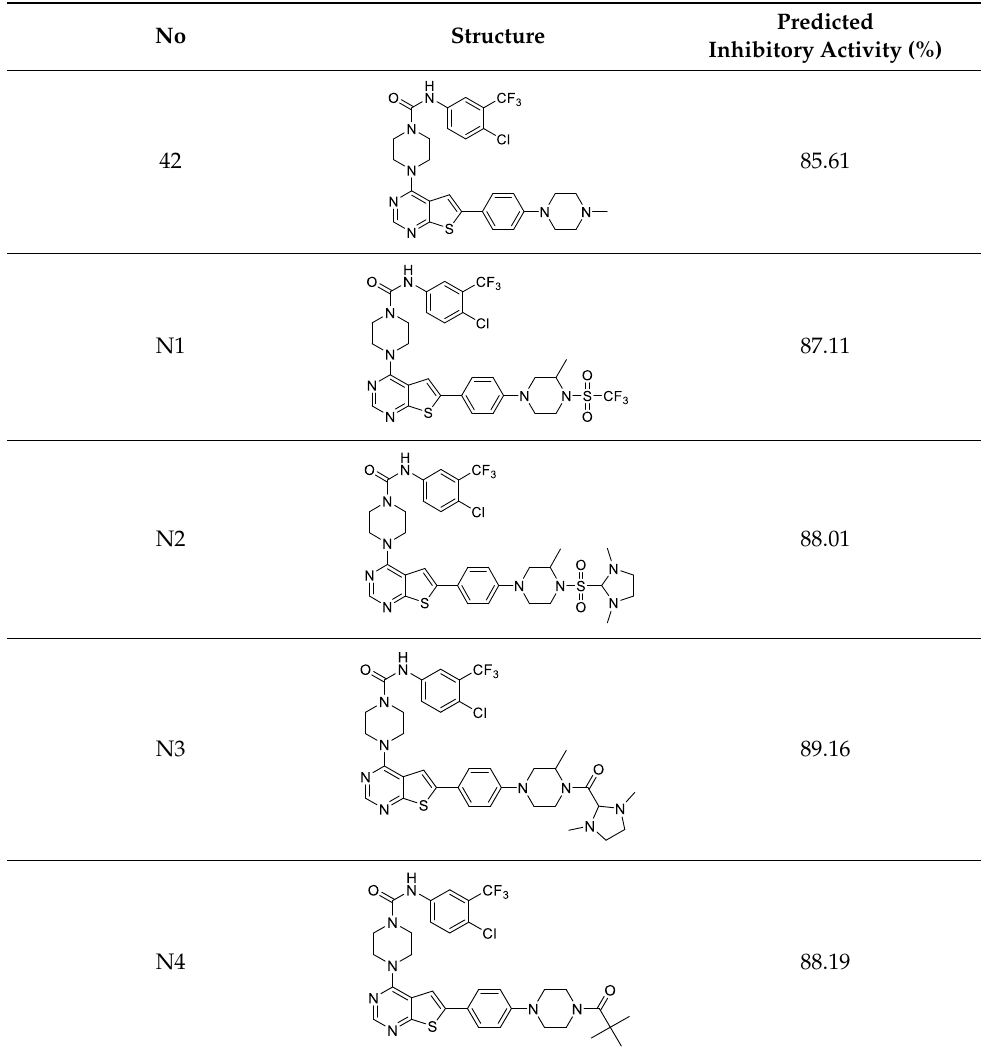
Table 4. The structures and the predicted inhibitory activities for the most active compound 42 and the newly designed inhibitors N1 - N14 .